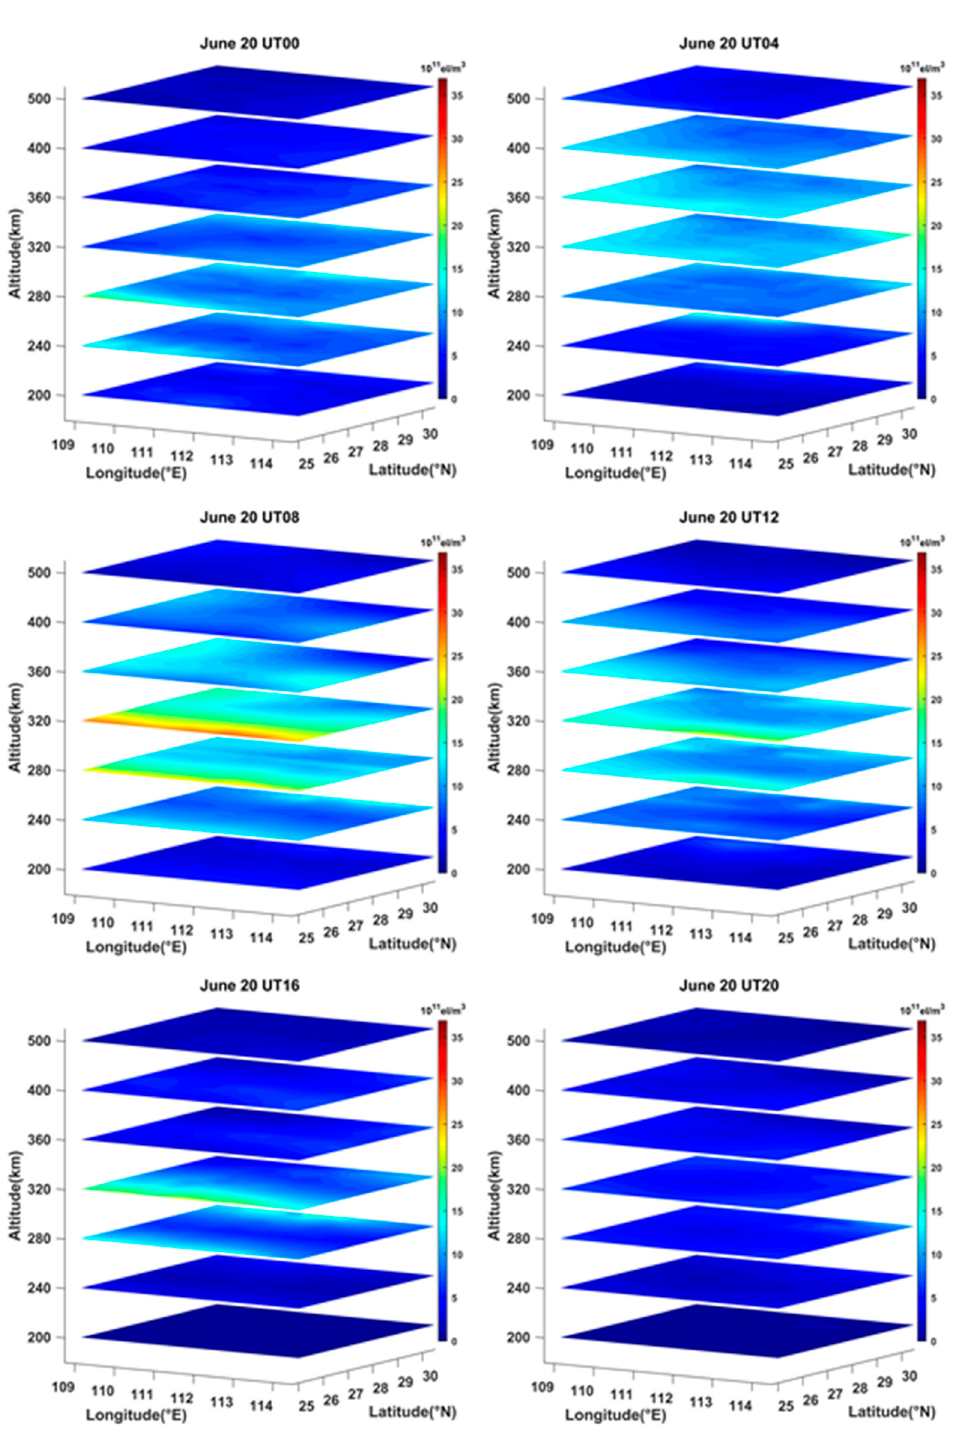
Figure 7. Time-series variation of three-dimensional IED distributions in the reconstructed region on June 20, 2015.